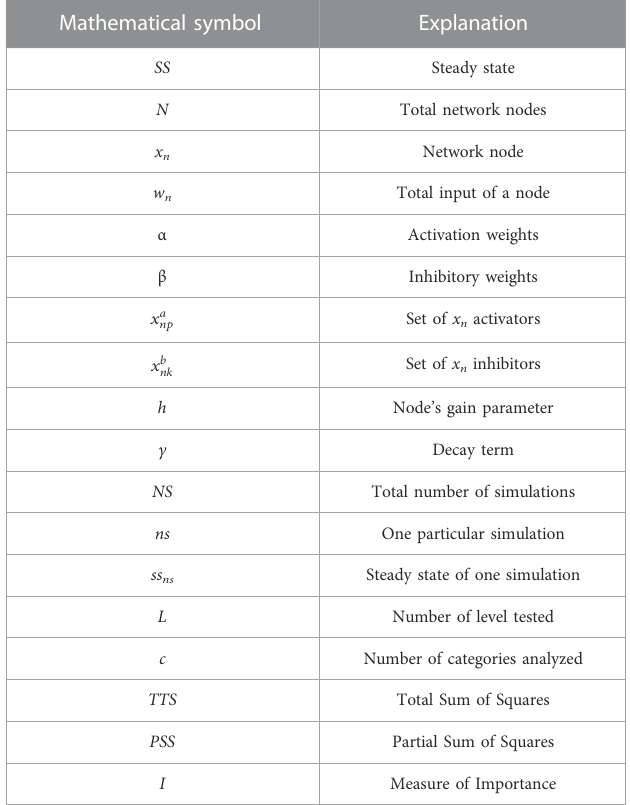
TABLE 3 Summary of mathematical